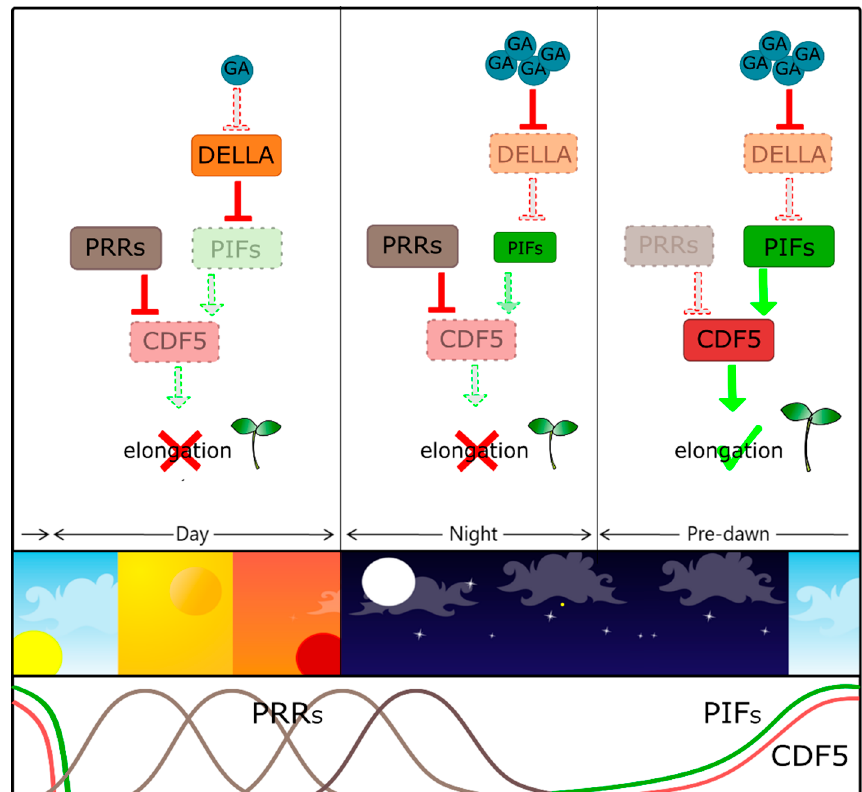
Figure 2. CDF5 promotes hypocotyl elongation in a clock-dependent manner. Expression of CDF5 is antagonistically regulated by both PIFs and PRRs, which directly interact, in order to control hypocotyl elongation during the light / dark cycles. From morning to dusk: accumulation of DELLA proteins, due to the absence of GAs, represses PIFs. PRR proteins (PRRs) directly repress CDF5, leading to inhibition of hypocotyl elongation. During the night: GAs promote DELLA degradation and in turn, stabilisation of PIFs. PRRs inhibit the activity of PIFs in post-dusk phase, gating the hypocotyl elongation to pre-dawn (upper panel). Schematic representation of the PRRs, PIFs and CDF5 proteins temporal activity (lower panel) [96]. CDF5 (CYCLING DOF FACTOR 5), PRRs (PSEUDO-RESPONSE REGULATORS), PIFs (PHYTOCHROME INTERACTING FACTORS).